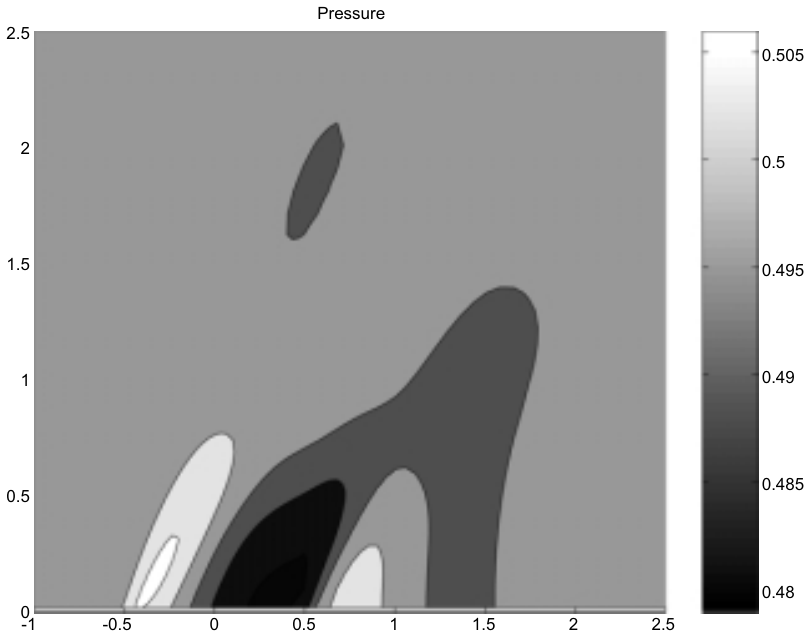
Fig. 12. Pressures after 20 second simulation using 16 modes with δ 1 = 0 . 005